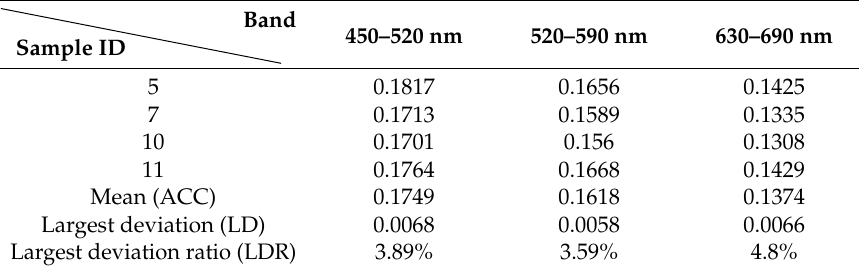
Table 8. A i (Calibration coefficients) of Samples 5, 7, 10, and 11.